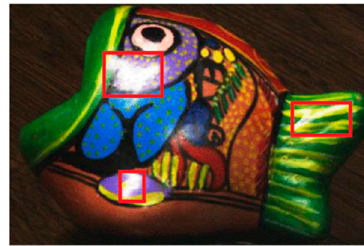
Figure 1. Target highlight areas to improve dynamic range (red box).